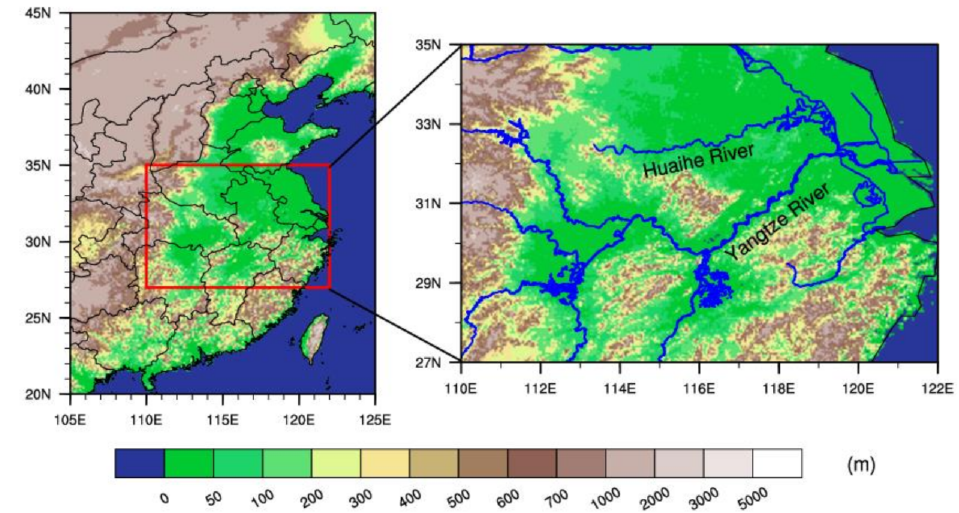
Figure 1. Location of the Yangtze–Huaihe River Valley (110–122 ◦ E, 27–35 ◦ N) in eastern China and its topography (color shading represents